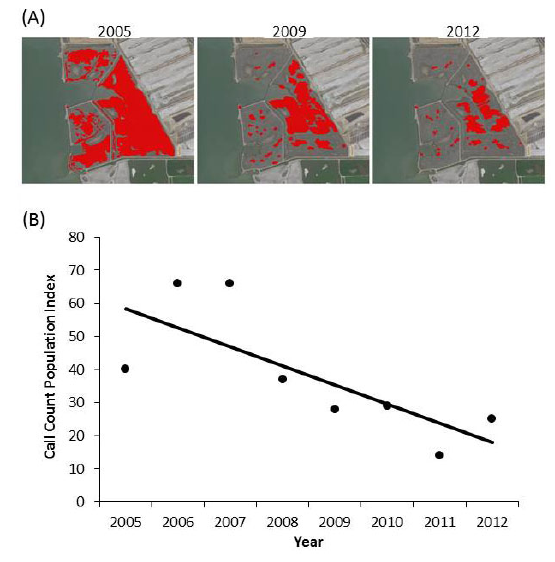
Fig. 4 . Extent of habitats dominated by invasive Spartina delineated from aerial photography (shown in red) before treatment in 2005, after initial treatments in 2009, and after near eradication in 2012 (A); and call- count survey detections and trend (−5.8 birds per year) within Cogswell Marsh (B).